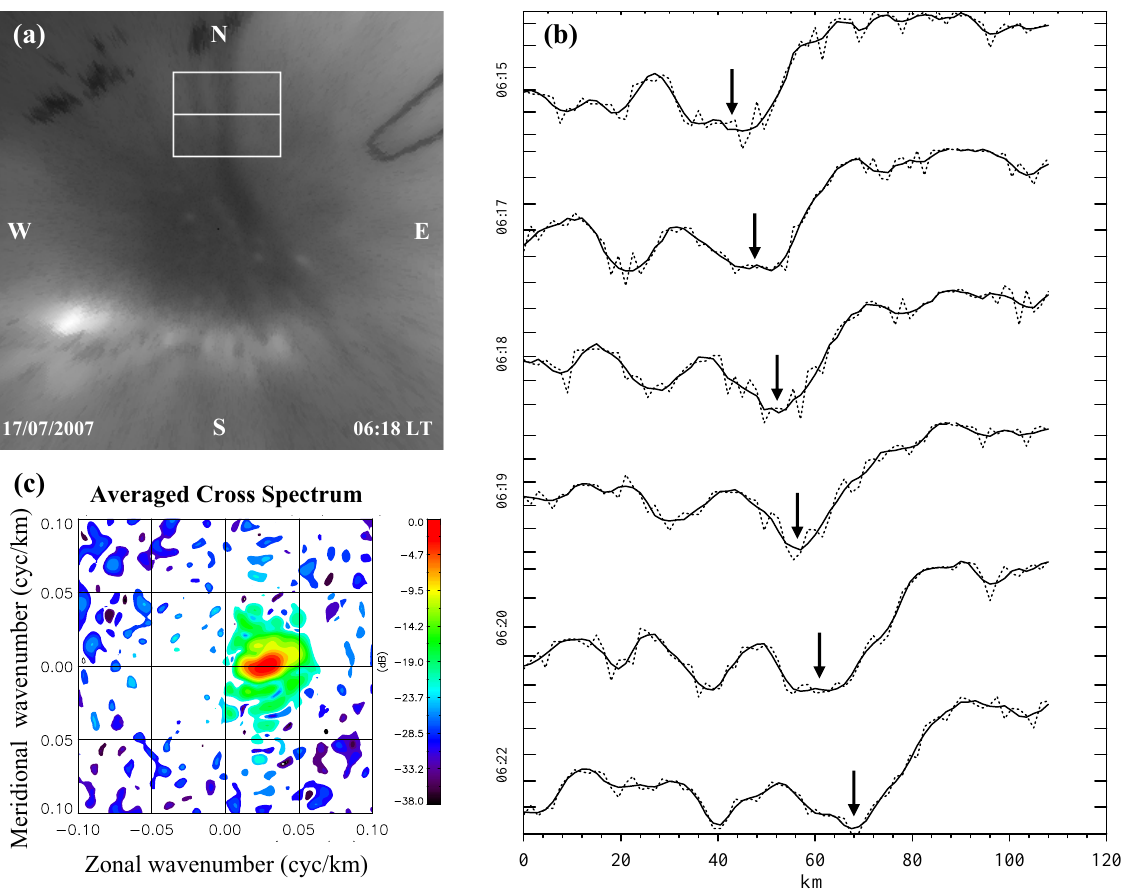
Fig. 2. Analysis of the mesospheric front observed at Ferraz station during the night 16–17 July 2007. (a) One of the images used to obtain the gravity wave parameters. The selected area in the box represents the portion of each image where the FFT analysis was applied. (b) Relative intensity profiles, obtained from a line orthogonal in the wave propagation direction, as indicated in the box drawn in panel (a). (c) Unambiguous cross-spectrum obtained by using of six airglow images.